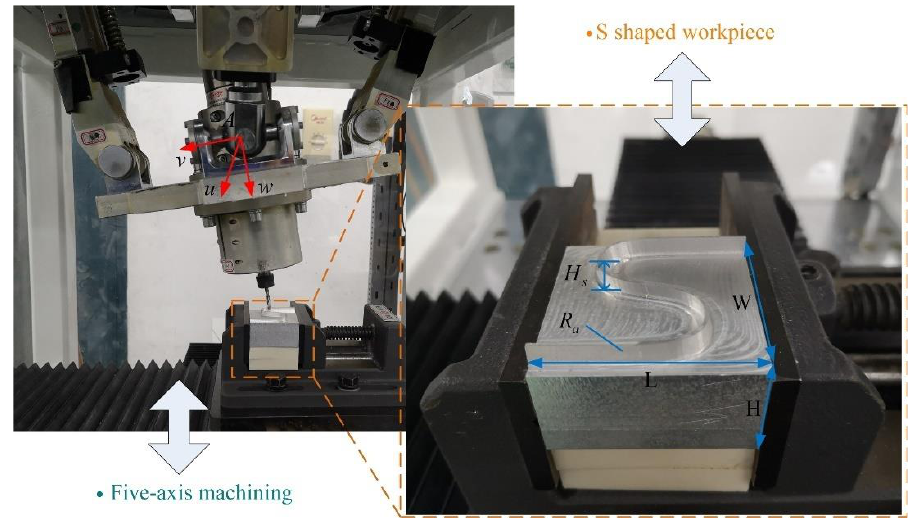
Figure 5. Five-axis machining of the S-shaped workpiece.